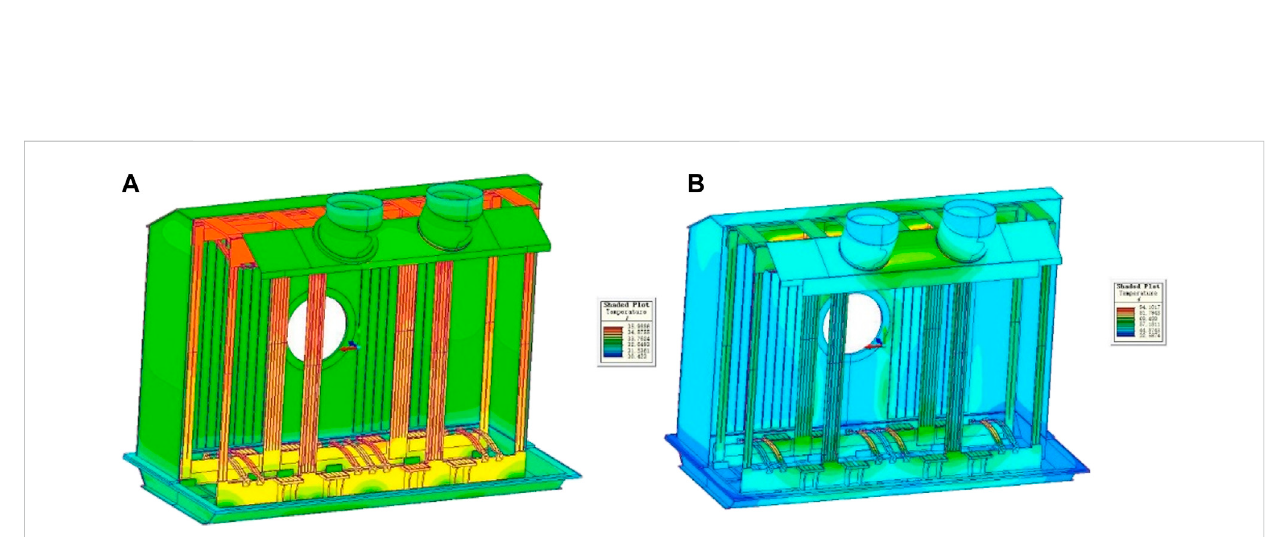
FIGURE 5 Cloud Map of Temperature Field Distribution in Oil Tank with Coupled Thermal Field at 30 ° C (A) 5% capacity (B) 85% capacity.